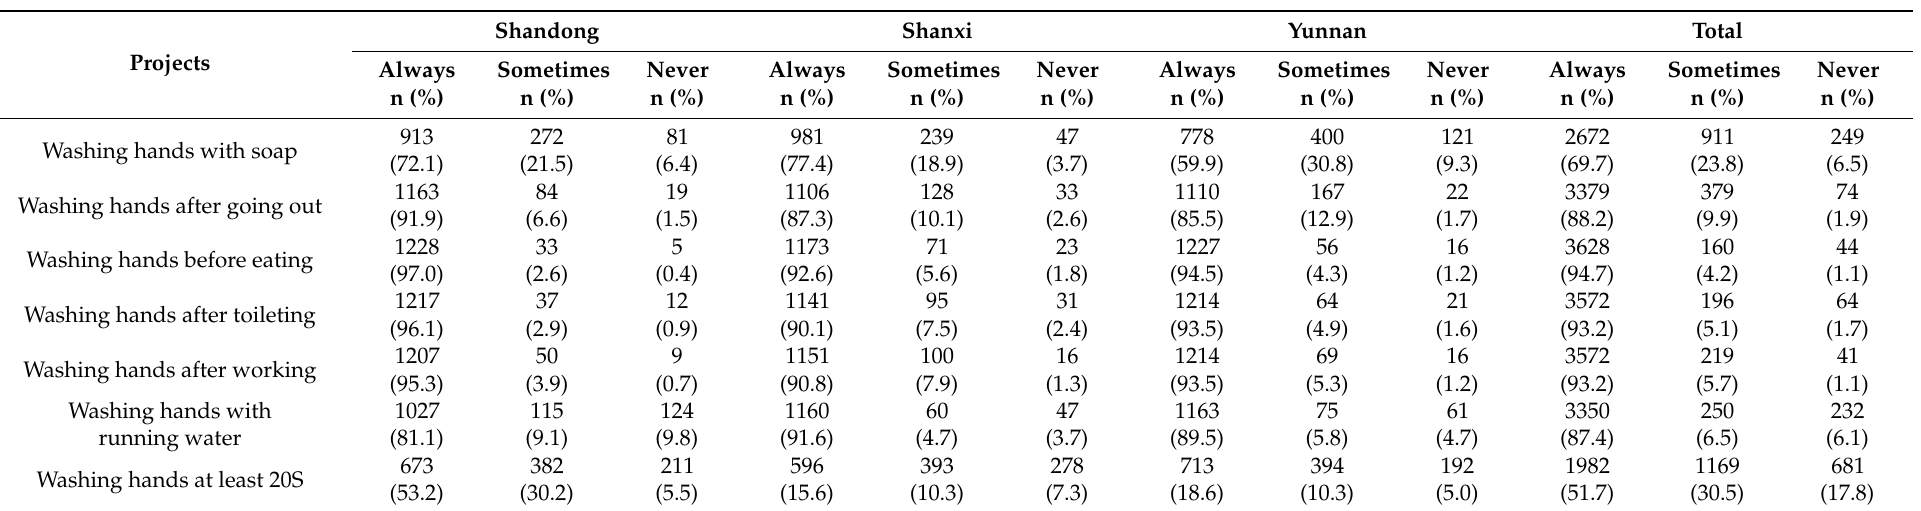
Table 5. Handwashing by 3832 rural